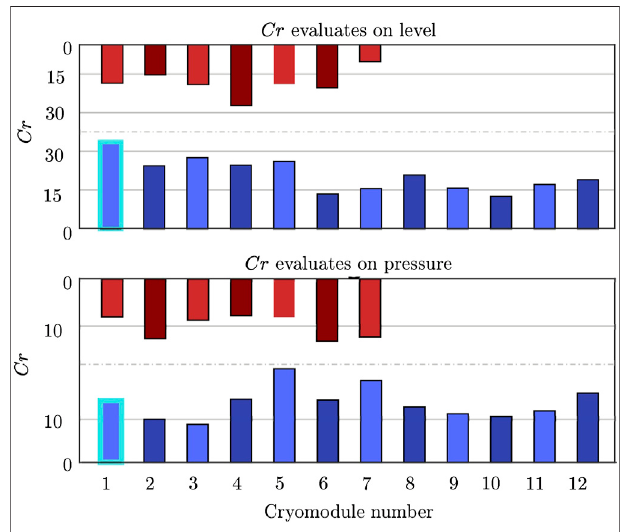
FIGURE3| Evaluationofthecriteria Cr oneachcryomodule. Thetype-A and type-B cryomodule are, respectively, plotted in blue and red. The blue highlighted element corresponds to the cryomodule investigated in Figure 2 .